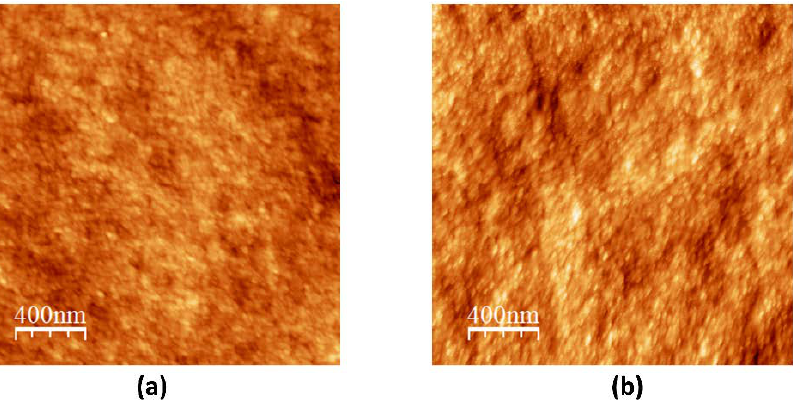
Figure 8. AFM images of pristine SBN42 glass samples after being broken in two. Panel ( a ) without and panel ( b ) with chemical treatment, chemical treated in HCl at 60 ◦ C for 30 min. The SBN42 sample series from the same batch underwent heat treatments at 600 ◦ C and 650 ◦ C for 2 h, 4 h, 6 h, 18 h, and 24 h. Imaging these annealed samples before immersion in HCl did not reveal the same underlying structure as the pristine one. However, a rich structure is revealed after chemical treatment in HCl acid. Figure 9 presents the series of AFM images of the sample after annealing and immersing in HCl acid. These images confirm the occurrence of APS in SBN42. Moreover, the sample’s structure evolves with annealing time and temperature. For a fixed temperature, the structure coarsens as annealing time increases. The structure displayed in the AFM images resembles that of a spinodal decomposition, which is also evidenced by Elmer [122] using SEM.